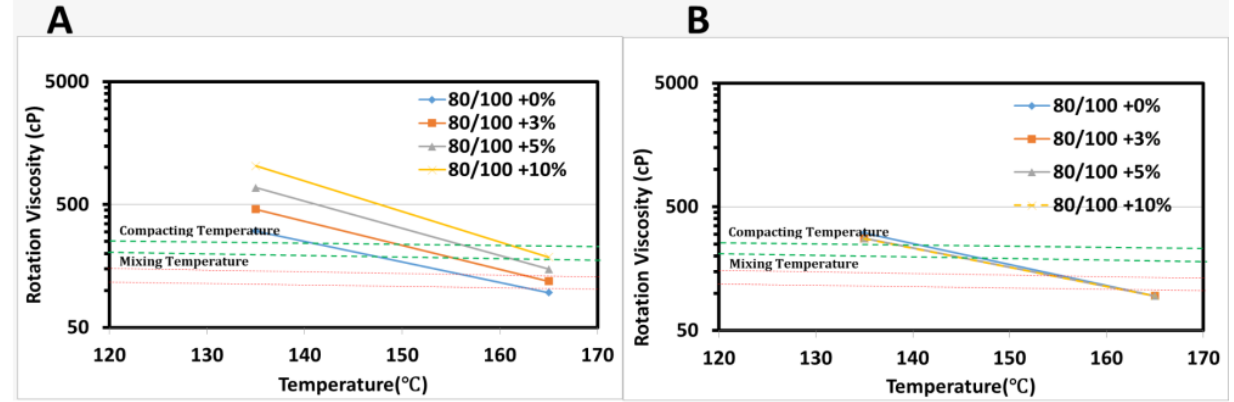
Figure 4. Viscosity-temperature curve for 150 µm PET: ( A ) dry mix mechanism, ( B ) wet mix mechanism.